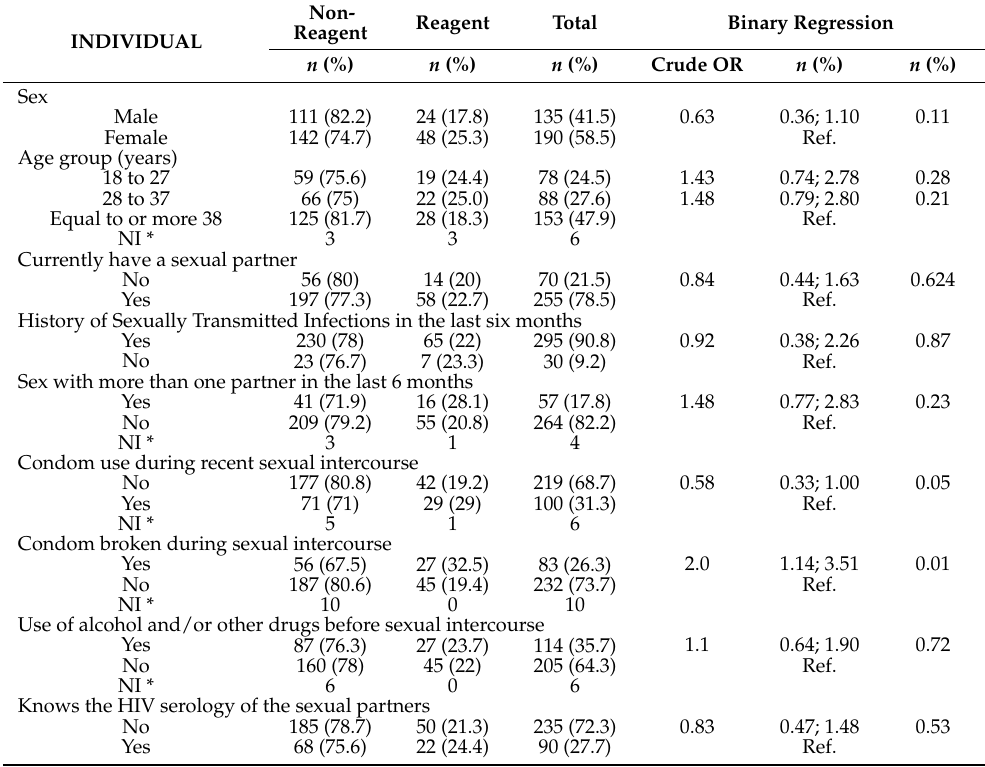
Table 2. Individual factors associated with serology for C. trachomatis among riverine, in the Brazilian Amazon, 2020–2021.